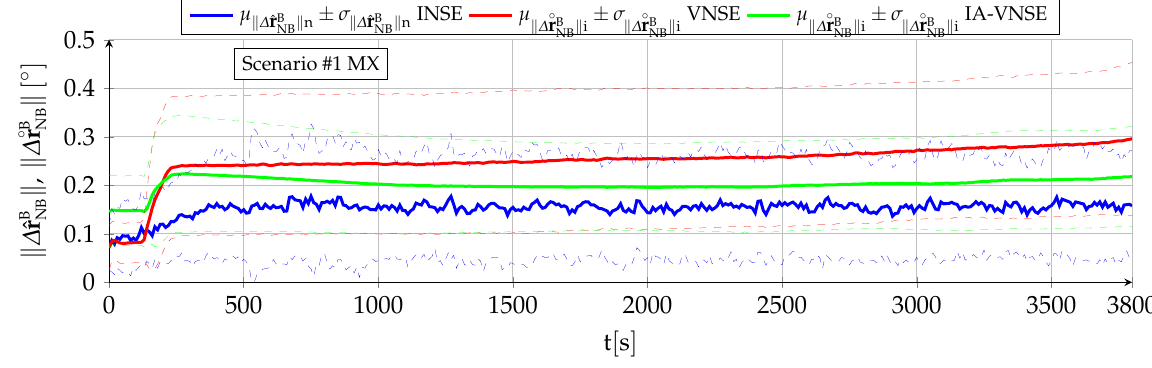
Figure 8. Body attitude INSE, VNSE, and IA-VNSE for scenario #1 MX (100 runs).